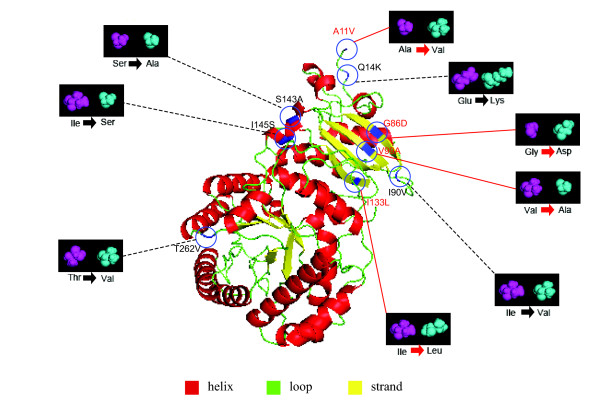
Positively selected sites in the RbcL subunit of the Podocarpaceae ancestor. Four positive selected sites of the Podocarpaceae ancestor are highlighted in red arrows. The 3D imagines of the ancestral and current amino acid residues are represented in purple and cyanine, respectively. The ancestral amino acid residues are inferred by the DAMBE package and the ancestral state reconstruction (ASR) molecule on Datamonkey 2010 website for the Podocarpaceae ancestral node [28,82]. The three domains are colour coded differently. Positively selected sites are indicated with lines, whereas the potential ones are with black dotted lines.